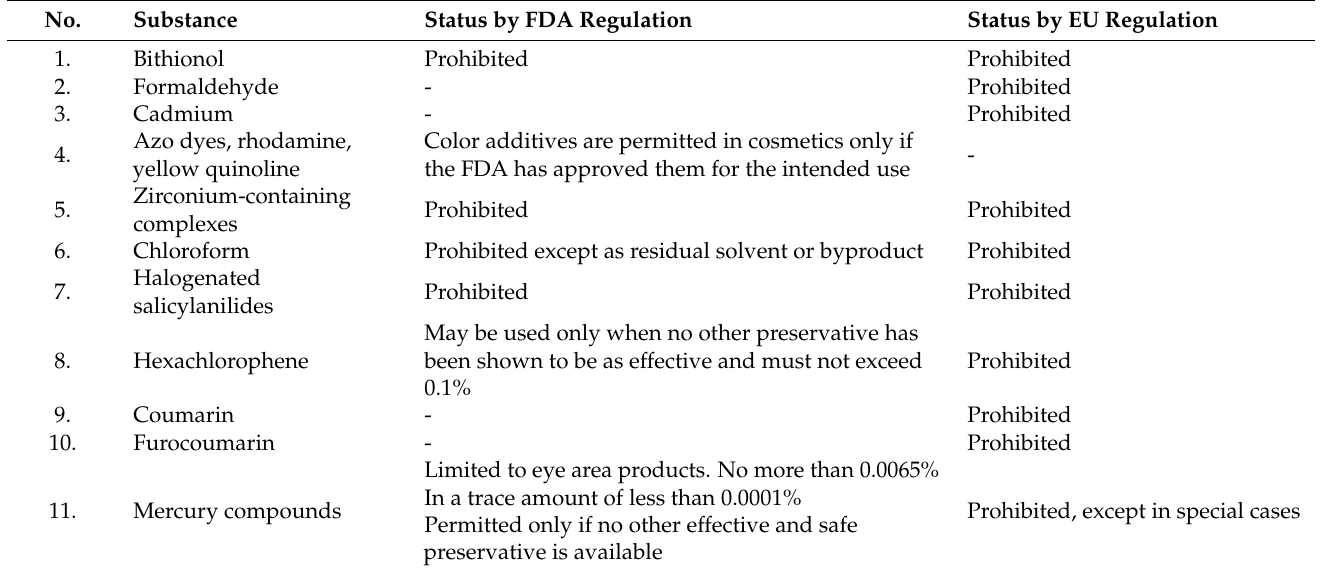
Table 1. A list of some of the ingredients restricted or prohibited by the U.S. FDA and